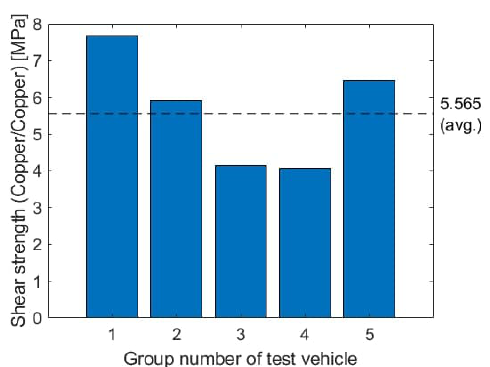
Figure 12. Shear strength per interconnection.